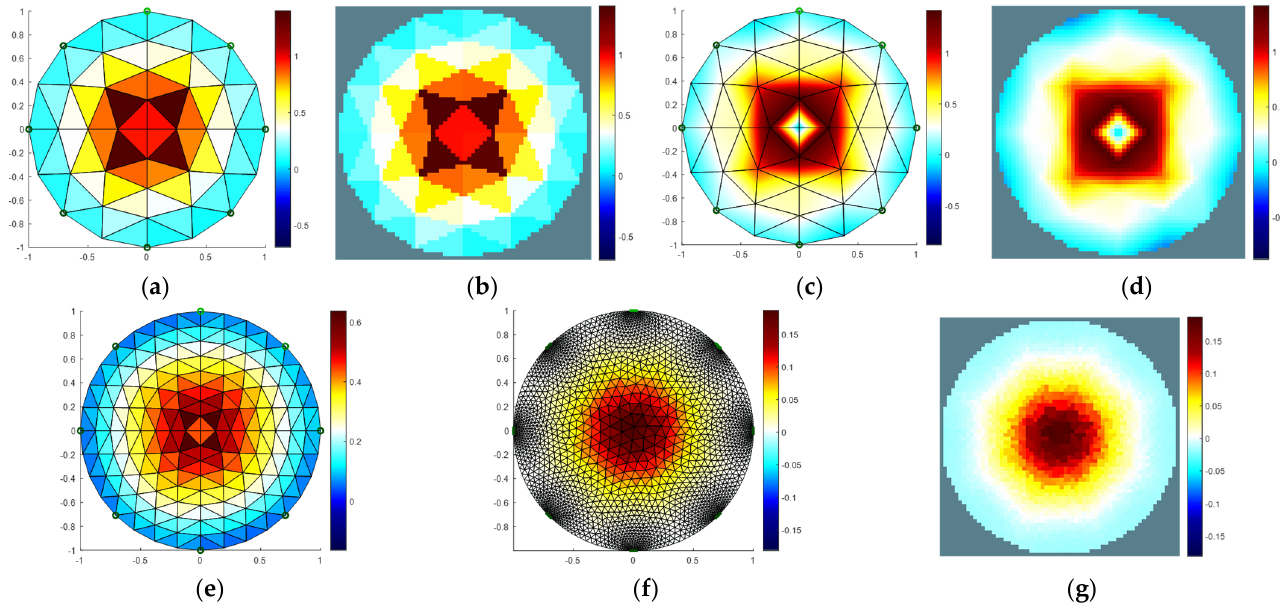
Figure 23. Reconstructed images of a carrot slice at the centre of an EIT domain for different FEM models at 80 kHz, 1 mA, and 2 Vpp excitation. ( a ) FEM (a2c0, 8)-elements, ( b ) corresponding reconstructed slices, ( c ) FEM (a2c0, 8)-nodes, ( d ) corresponding reconstructed slices, ( e ) FEM (b2c0, 8)-elements, ( f ) FEM (d2d4c, 8)-elements, and ( g ) corresponding reconstructed slices. A blurred reconstructed image was observed for the reconstruction onto nodes, on the other hand, a good reconstruction was made onto elements. A clear reconstructed image of the carrot slice with an accurate shape was found using a ‘distmesh’ generator FEM model such as ‘d2d4c’ considering the reconstruction onto elements. Overall, the error was decreased by increasing the number of elements.